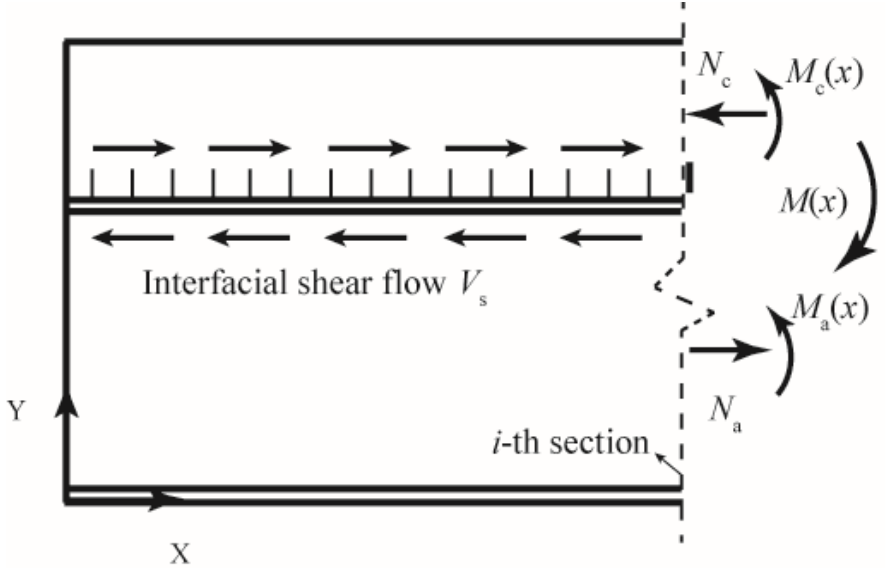
Figure 6. Internal force analysis for the composite beam.